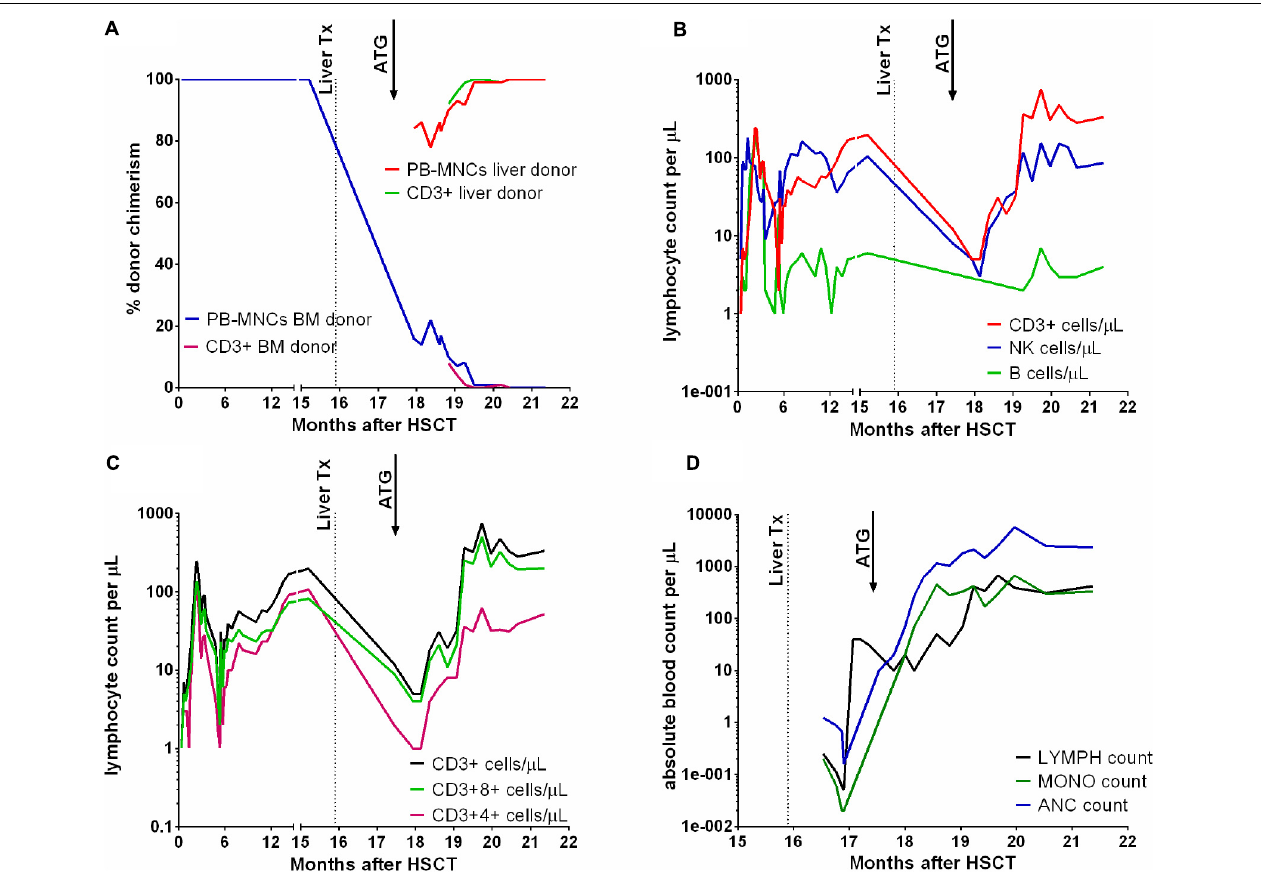
FIGURE 1 | Chimerism results in peripheral blood mononuclear cells (PB-MNCs) and T lymphocytes (A) . T, B lymphocyte and NK cell counts (B) , and T CD3+4+ and CD3+8+ counts (C) after HSCT and OLT. Absolute lymphocyte (LYMPH), monocyte (MONO) and neutrophil (ANC) counts in the peripheral blood (D) . Dotted lines mark the time of liver transplantation, and arrows indicate the time of ATG